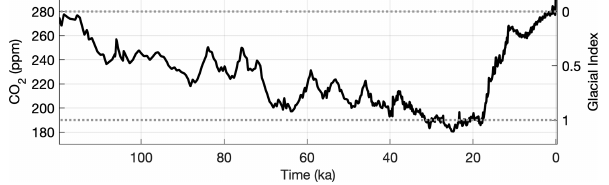
Figure 2. Atmospheric CO 2 concentrations during the LGC from Bereiter et al. (2015) and the corresponding glacial index values. A glacial index value of 1 represents “full glacial conditions” corre- sponding to an LGM climate. A glacial index value of 0, or “full interglacial conditions”, represents a PI